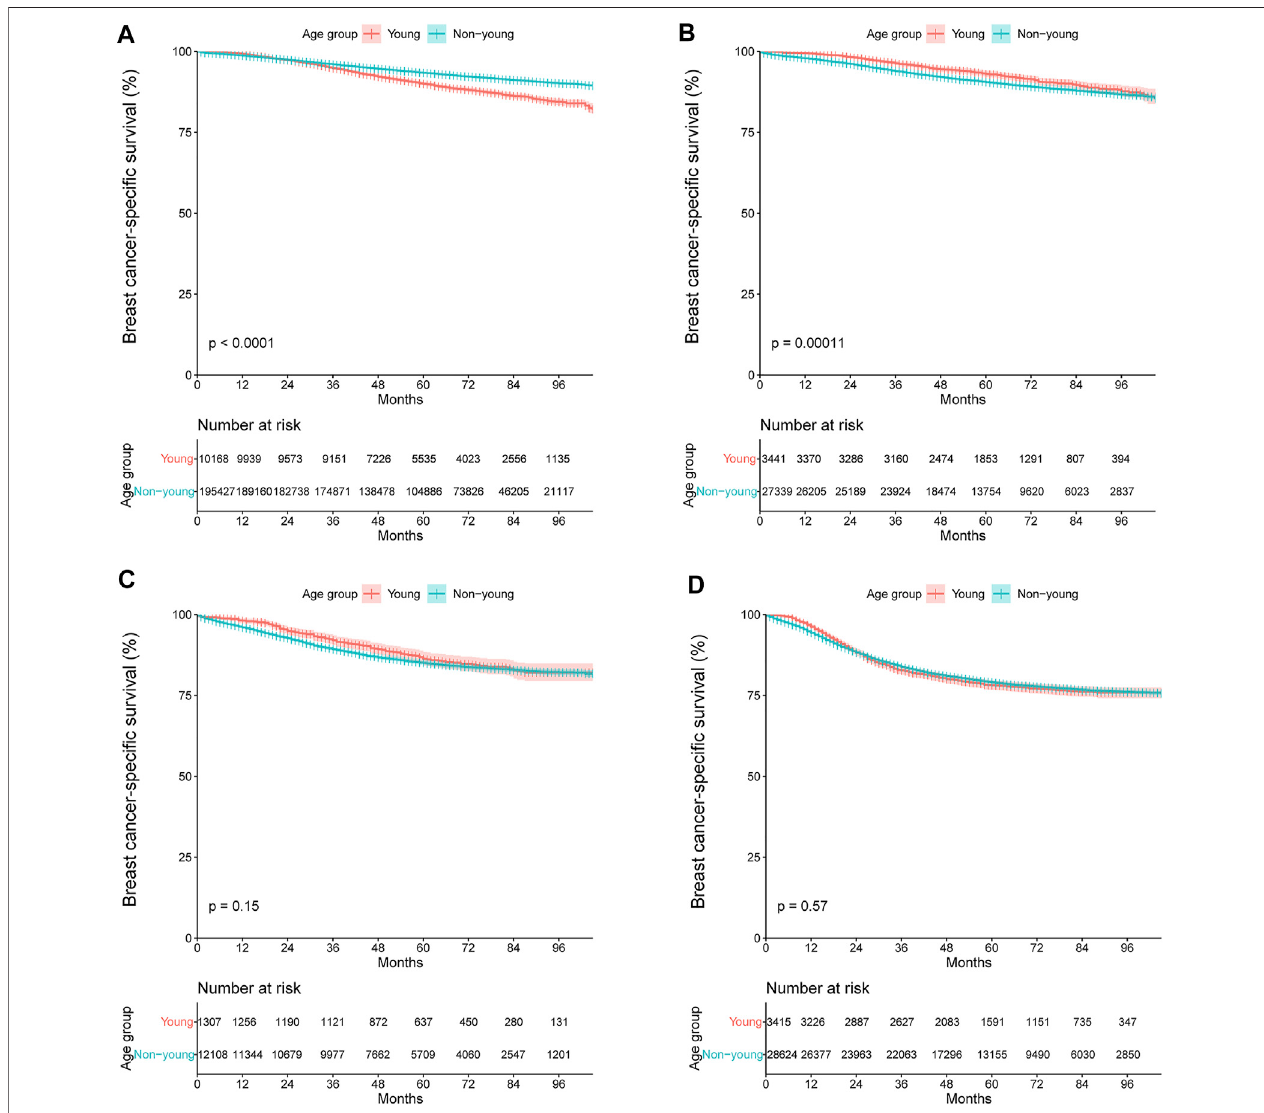
FIGURE6| Kaplan – Meiercurvesofbreastcancer-speci fi csurvivalstrati fi edbyagegroupfor (A) HR+/HER2-, (B) HR+/HER2+, (C) HER2-enriched,and (D) triple- negative breast cancer. +, positive; − , negative; HR, hormone receptor; HER2, human epidermal growth factor receptor 2.